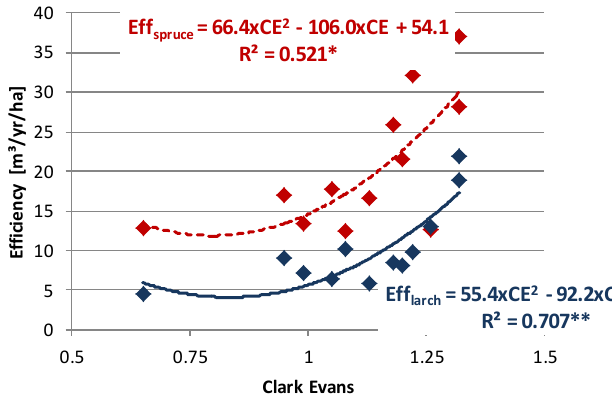
Figure 6. Relative complementarity at stand ages of 50, 110, and 170 years, depending on the species proportion. Forests 2018 , 9 , x FOR PEER REVIEW